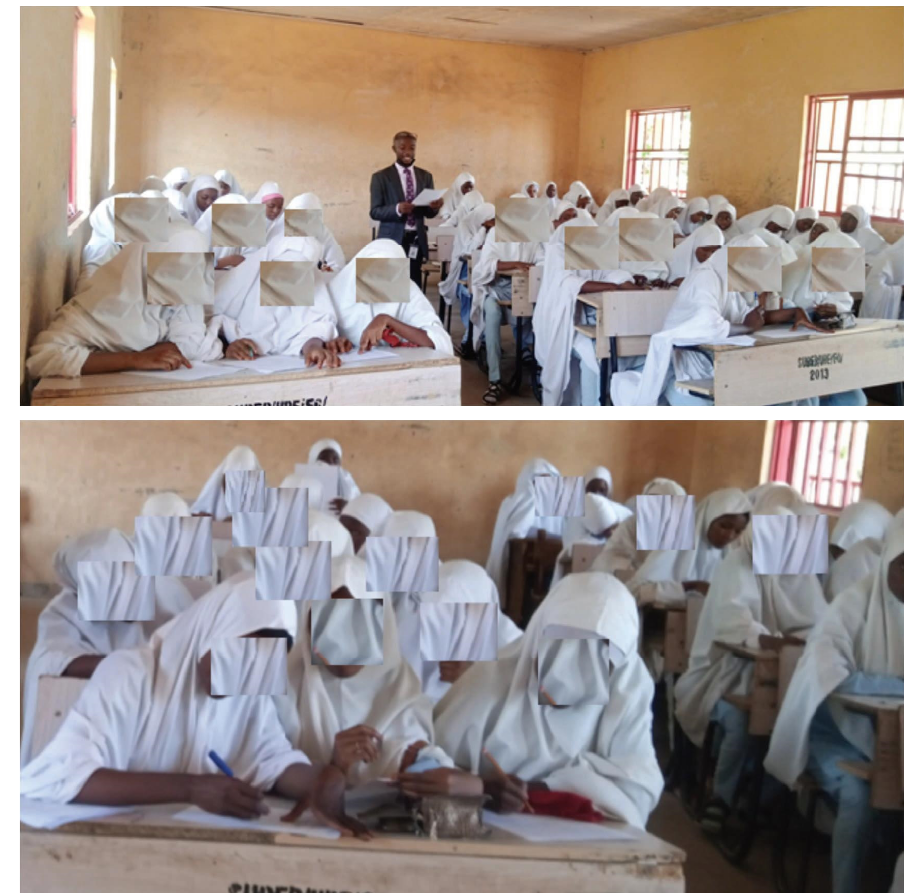
Figure 3: Sensitization on the health efect of HPV and cervical cancer conducted at Government Girls Secondary School Gandu, Kano State,